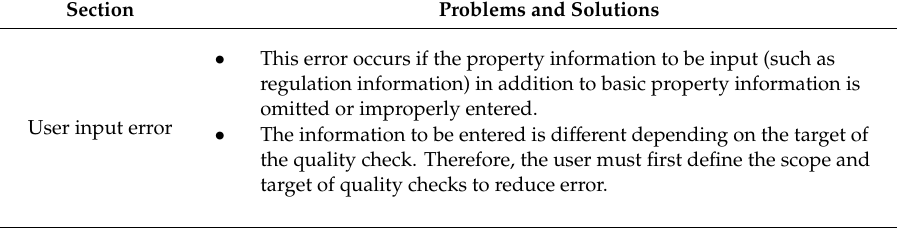
Table 12. The results of quality checks against design check criteria.